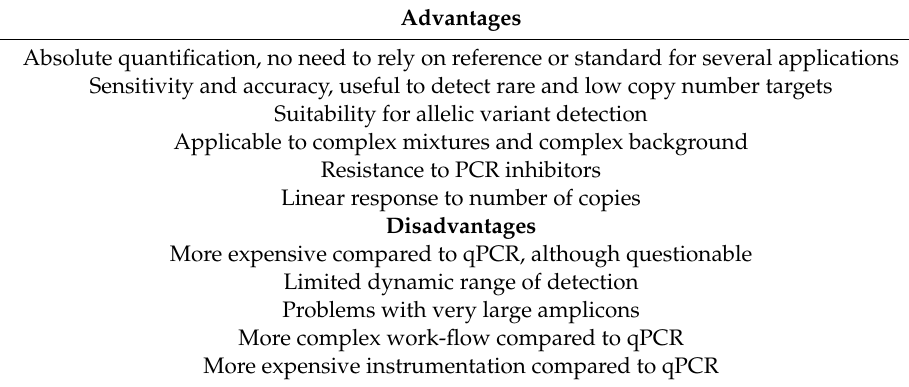
Table 3. Main advantages and disadvantages of dPCR